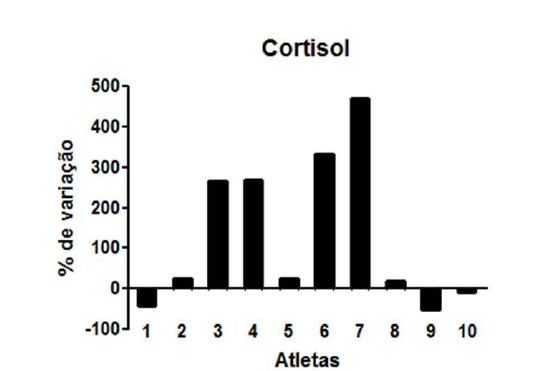
Figura 2. Percentual de variação individual